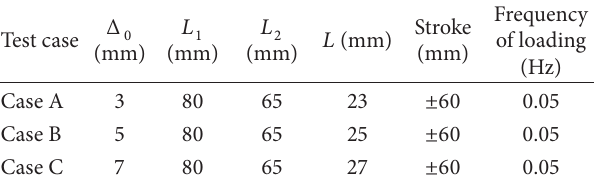
Table 1: Specification of test